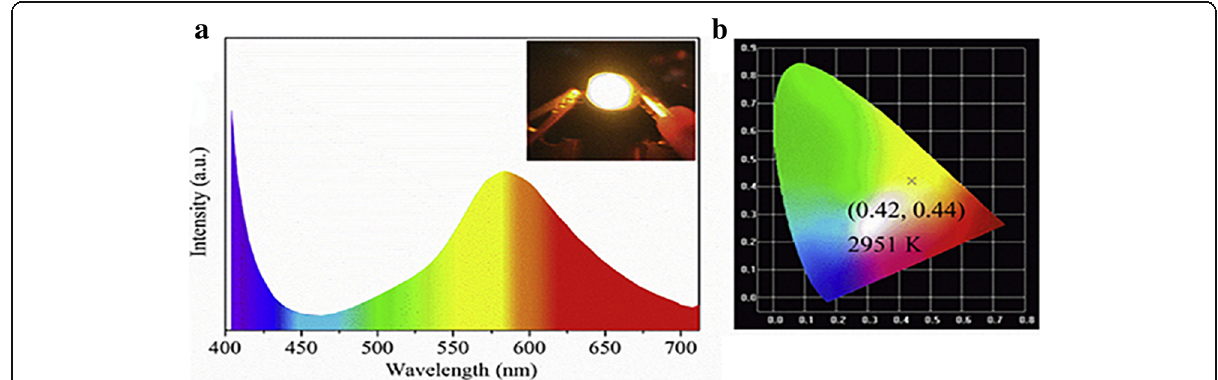
Fig. 18 The performance of WLED showed as a the emission spectrum and b for CIE chromaticity and CCT